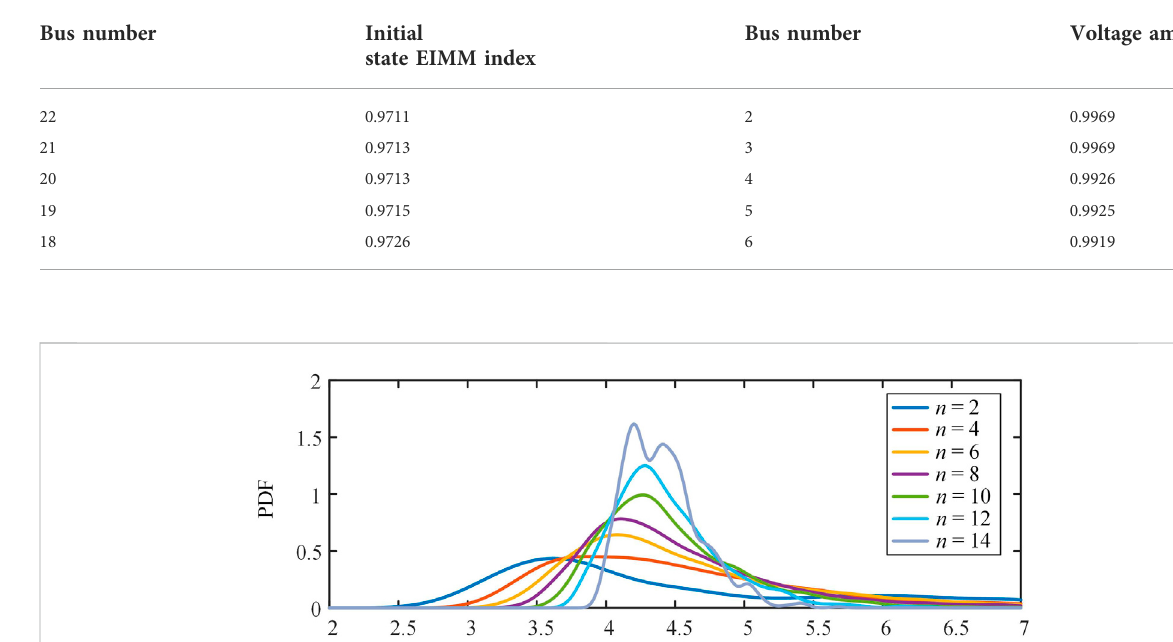
TABLE 1 Bus static voltage stability and voltage amplitude.